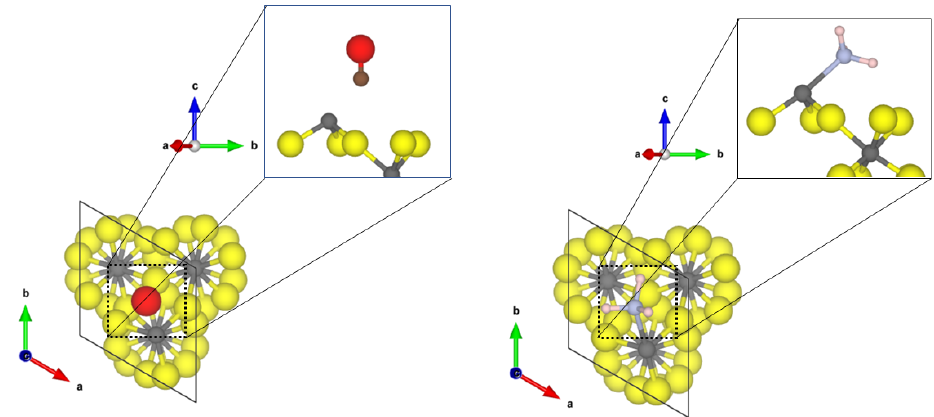
Figure 5. PBE-D3(BJ) optimized structures of the probe molecules CO ( left ) and NH 3 ( right ) on the α -AlF 3 -(0001) surface; yellow = fluorine, green = chlorine, grey = aluminium, blue = nitrogen, pink = hydrogen, brown = carbon, red =